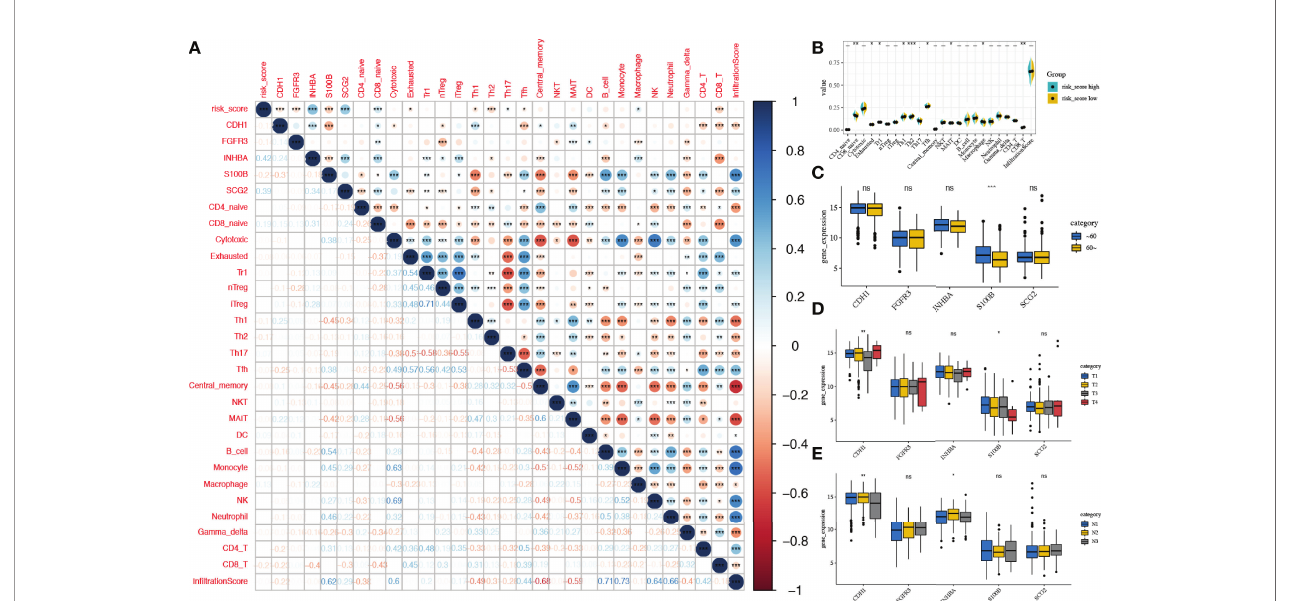
FIGURE 8 | Correlation of risk scores with immune microenvironment and Clinical characteristics. (A) Correlation between the expression of IRGs and the proportions of immune cell in fi ltration. (B) Comparison of the proportions of immune cell in fi ltration between risk score subgroups. (C – E) Expression of the fi ve candidate genes in different clinical subgroups (age, T-stage, N-stage) IRG, immune-related gene. *, **, *** and expanded form of "ns" denote p<0.05, p<0.01, p<0.001, and p ≥ 0.05,